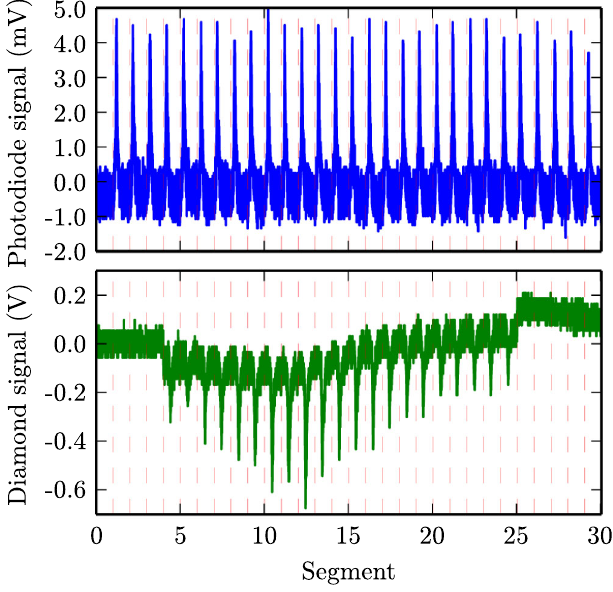
FIG. 9. Comparison of laser pulses recorded with a photodiode and the amplified signal at the diamond detector.